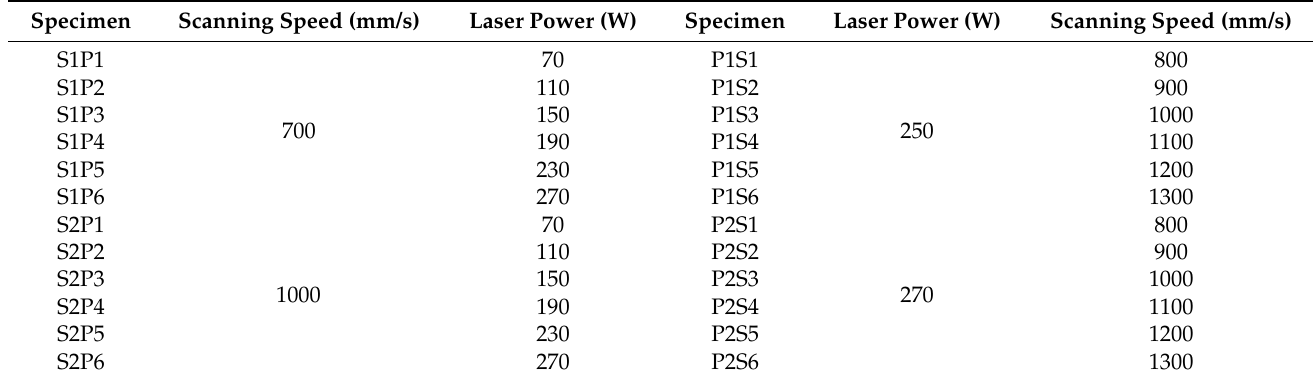
Table 3. Different combined process